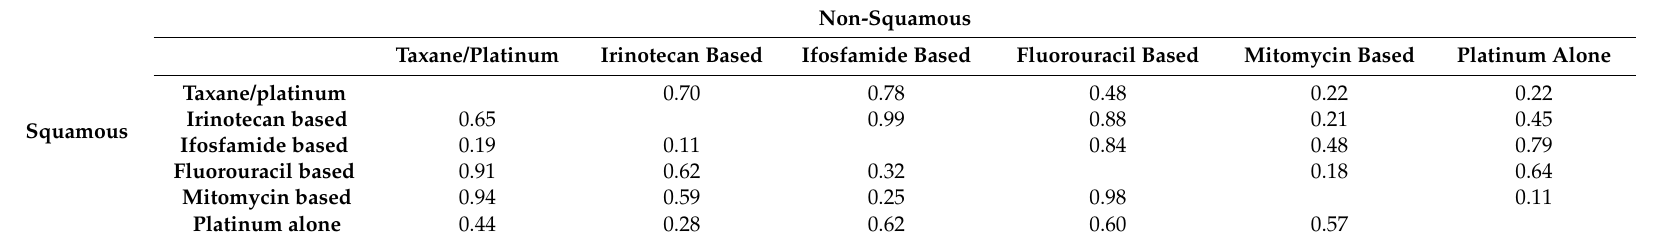
Table 5. Disease-free survival based on chemotherapy